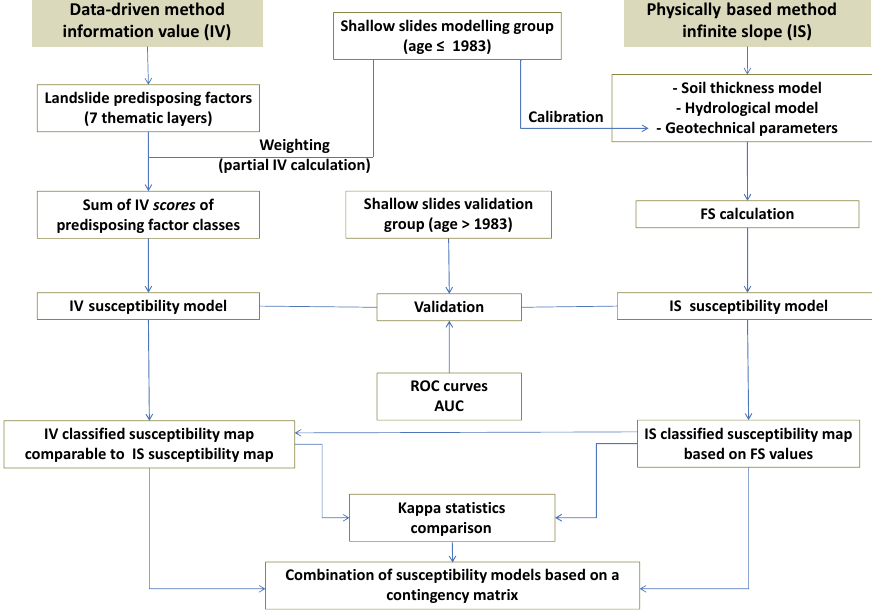
Figure 2. Methodological framework to compare and to combine statistical and physically based landslide susceptibility